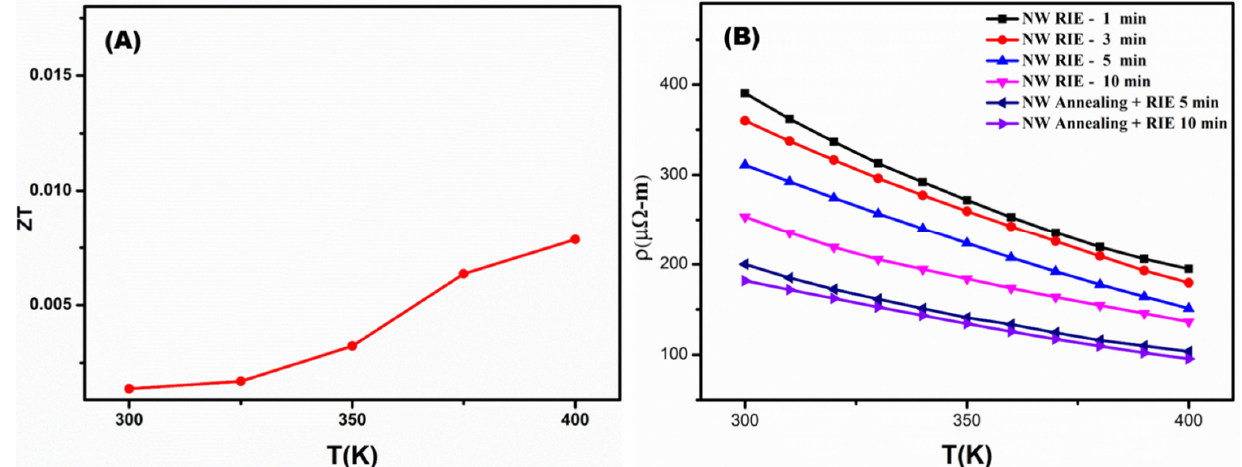
Figure 8. ( A ) ZT ‐ obtained InSb P ‐ NW as a function of temperature. ( B ) The resistivity of InSb P ‐ NWs was measured for different RIE times and annealing. Figure 8. ( A ) ZT-obtained InSb P-NW as a function of temperature. ( B ) The resistivity of InSb P-NWs was measured for different RIE times and